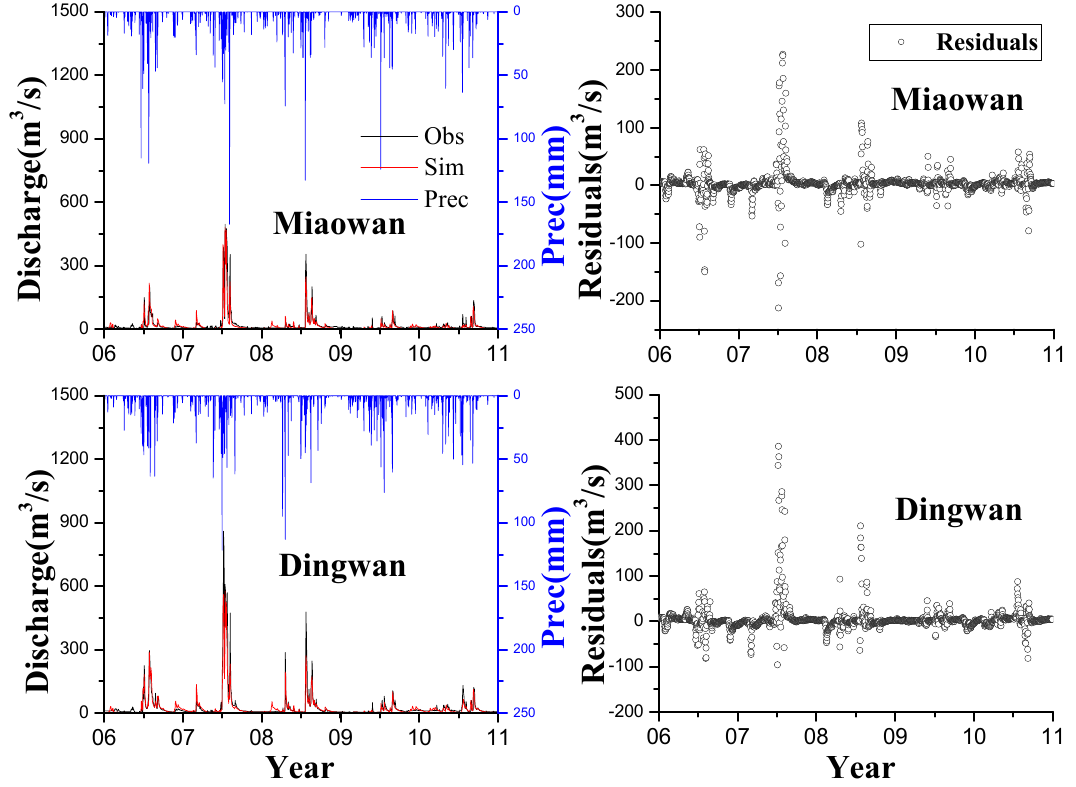
Figure 2. Daily discharge simulations at Miaowan and Dingwan stations in calibration (2006–2008) and validation (2009–2010) periods; residual plots are shown in the right panel.